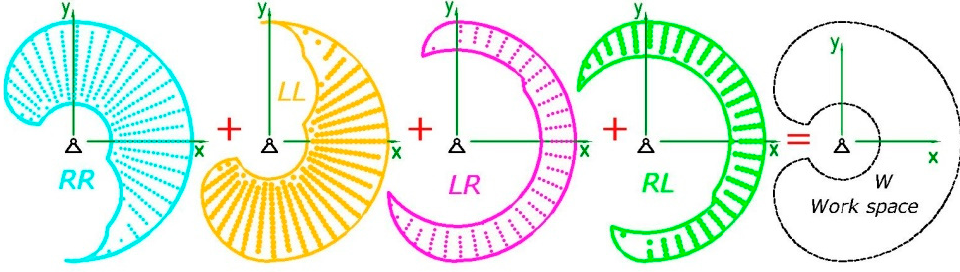
Figure 16. Basic types of IK solutions. Their union represents the robot’s workspace.